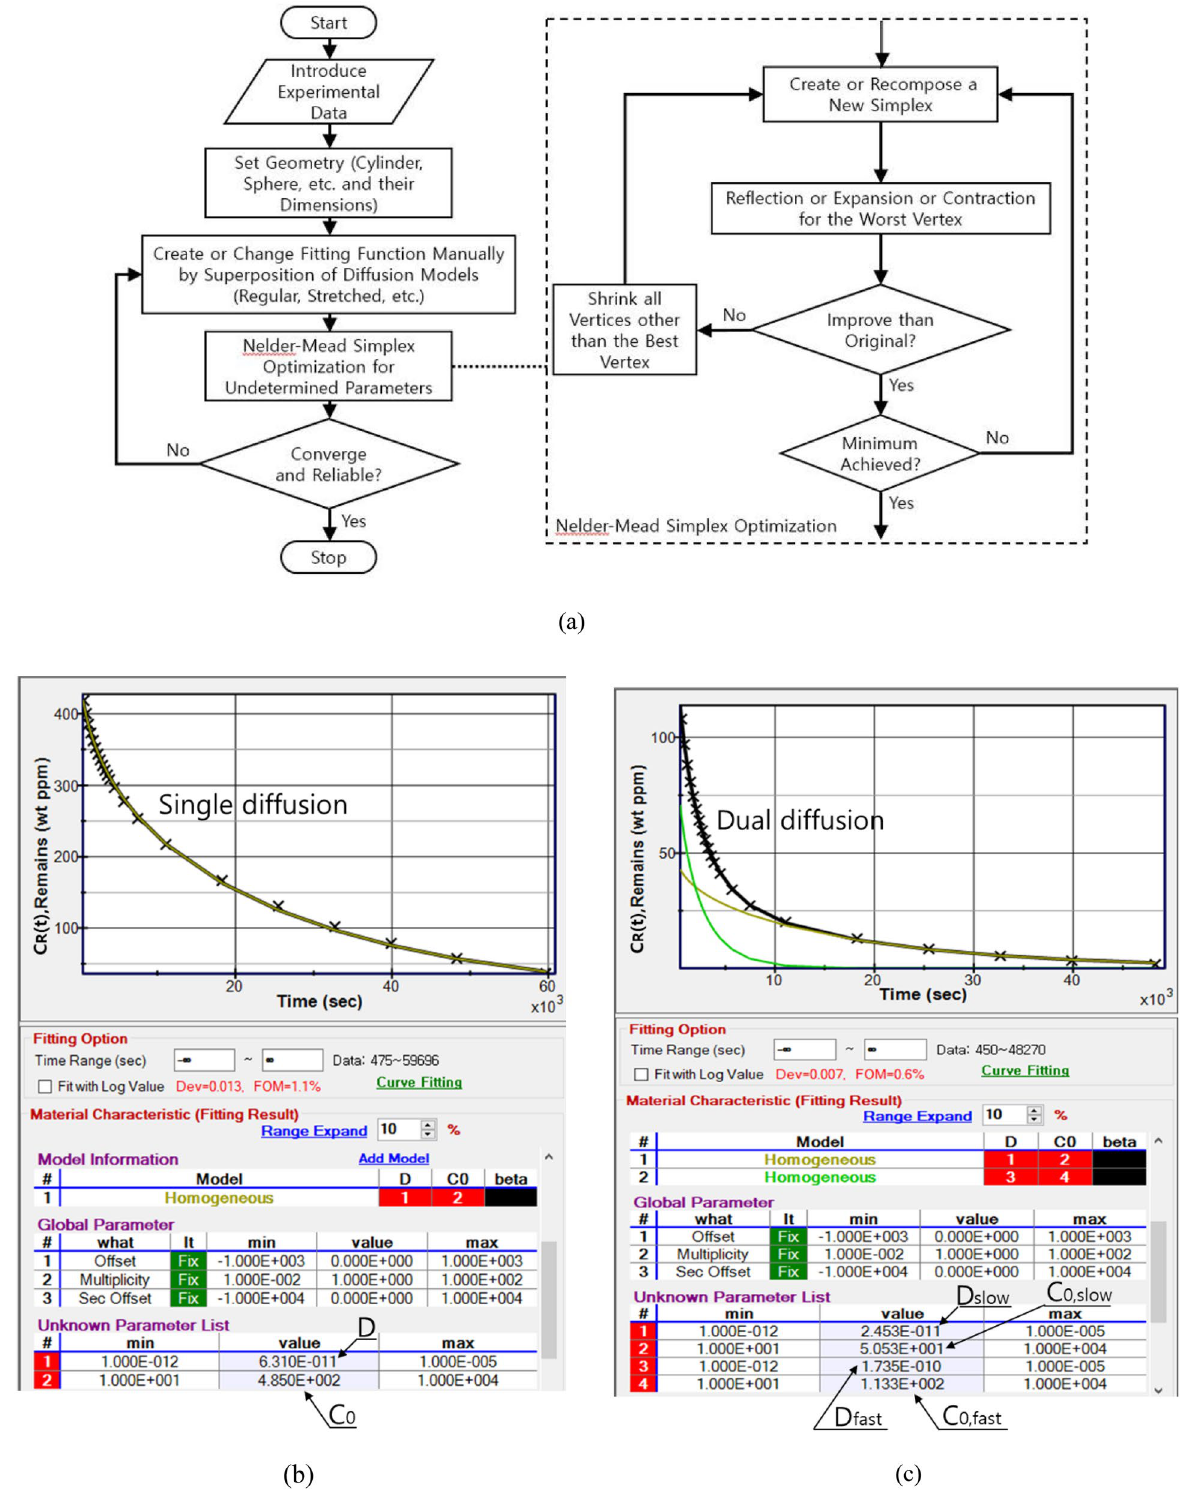
Figure 1. ( a ) Flow chart explaining the algorithm of the diffusion analysis program, application results of the program to obtain the C O and D by least squares regression for ( b ) single diffusion and ( c ) dual